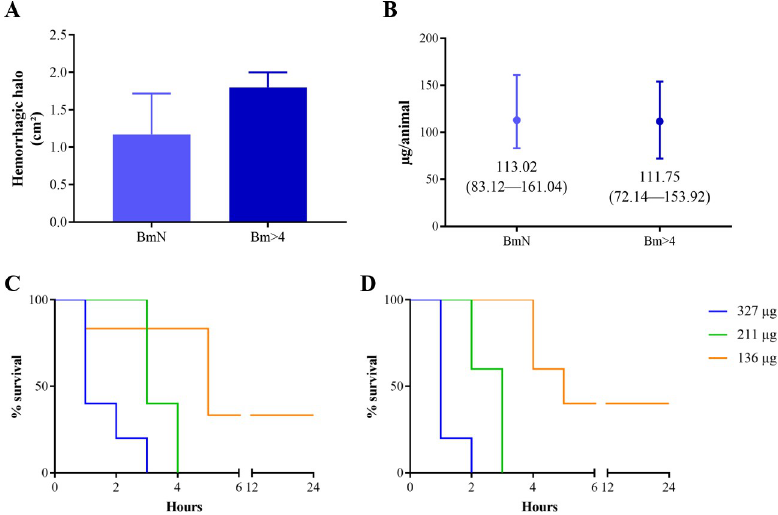
Fig 7. In vivo assays of neonates and adults B . moojeni venom. Hemorrhagic activity (A) was carried out by measuring the halos after intradermal injection of 20 μ g venom. Median lethal dose (B) was determined by intraperitoneal injection of different doses of venom and the use of probit to obtain the values. The mice were observed for 6 consecutive hours and the number of deaths registered at each hour and 24 h after the injection of BmN (C) and Bm > 4 (D)